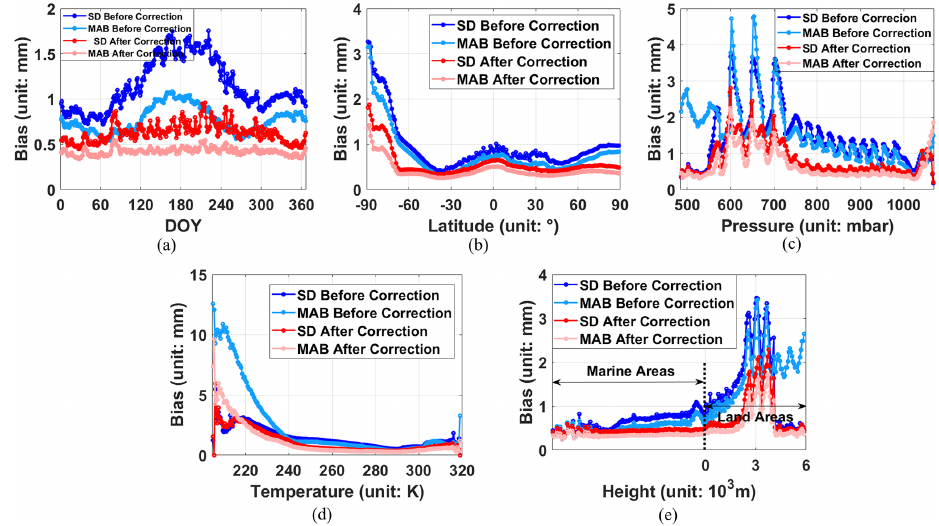
Figure 10. The MAB and SD of biases in different dimensions before and after correction over 2020. Panel (a) represents the global MABs and SDs on different DOYs, (b) represents the MABs and SDs at different latitudes, (c) represents the MABs and SDs in regions with different air pressures, (d) represents the MABs and SDs in regions with different temperatures, and (e) represents the MABs and SDs in regions with different